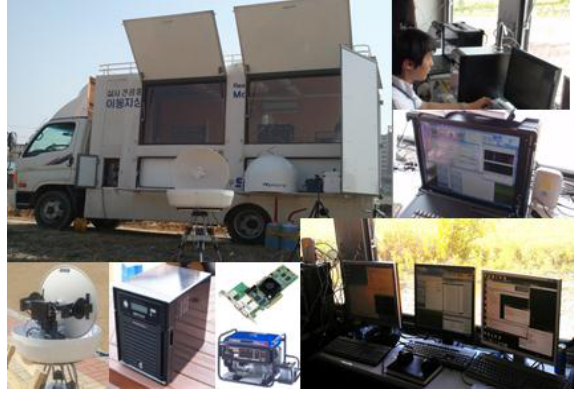
Figure 4. Ground Segment